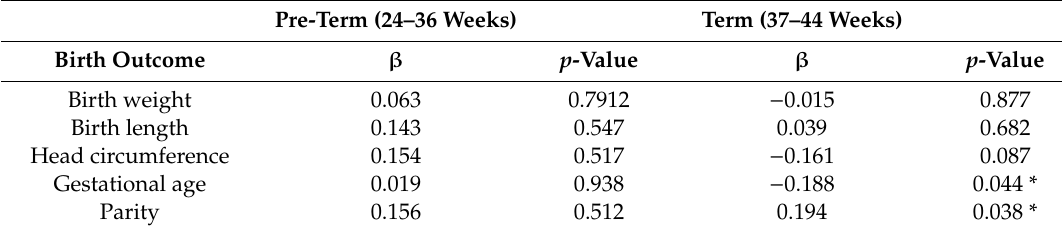
Table 3. Spearman’s rank correlation coe ffi cient ( p -value) of associations between maternal serum Al and birth outcomes (n =